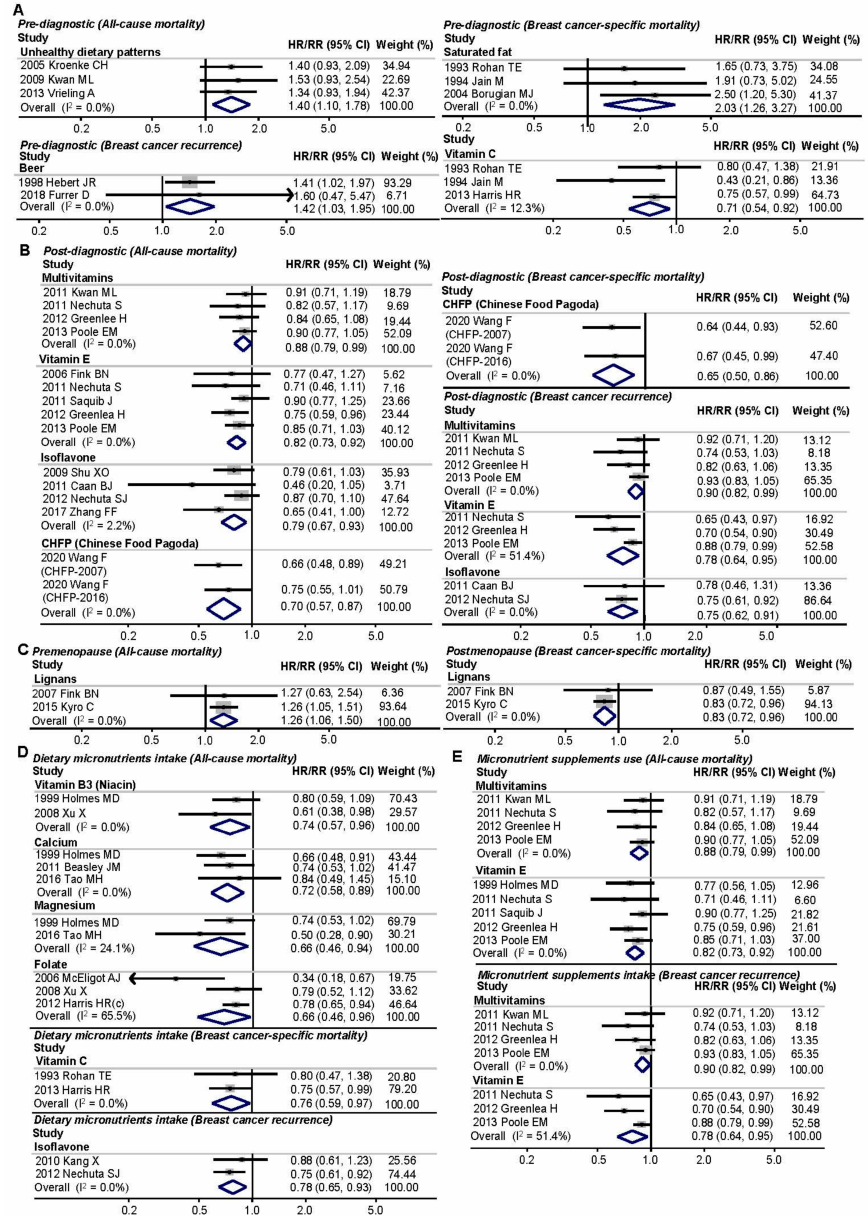
Figure 3. Forest plots of subgroup analysis for the associations between dietary factors and BC prognosis by prediagnostic ( A ) and postdiagnostic intake ( B ), menopausal status ( C ), and dietary ( D ) and/or supplement use of micronutrient intake ( E ) among breast cancer survivors. Abbreviations: HR, hazard ratio; RR, relative risk; CI, confidence